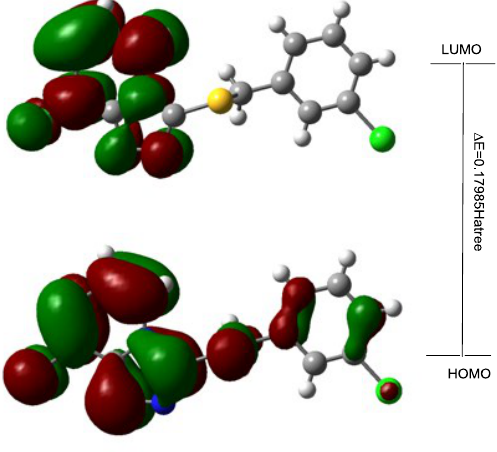
Figure 1. Frontier molecular orbitals of 2.